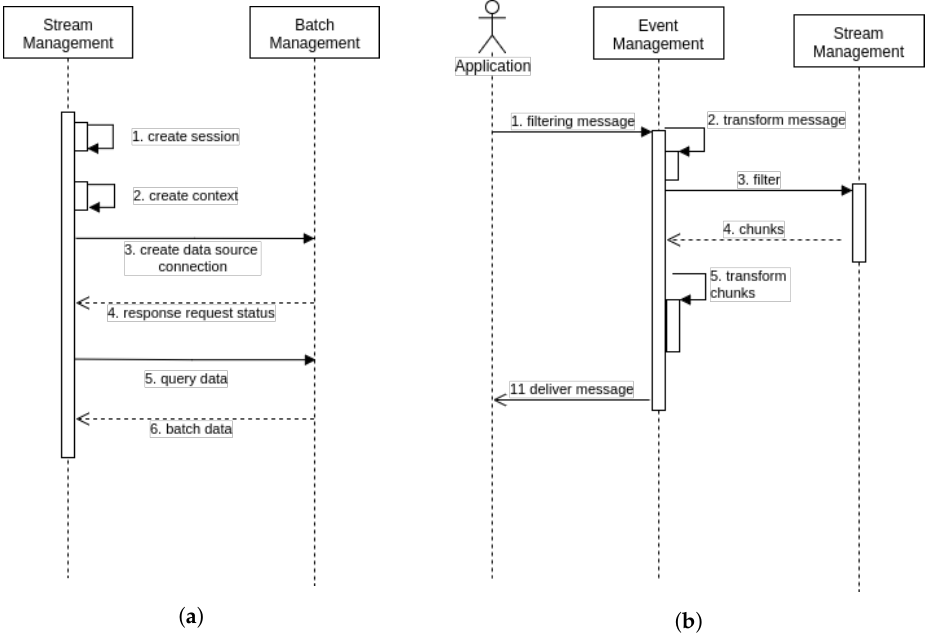
Figure 5. Interactions arranged in time sequence. ( a ) StrM and BM workflow; ( b ) Application, EM and StrM workflow.